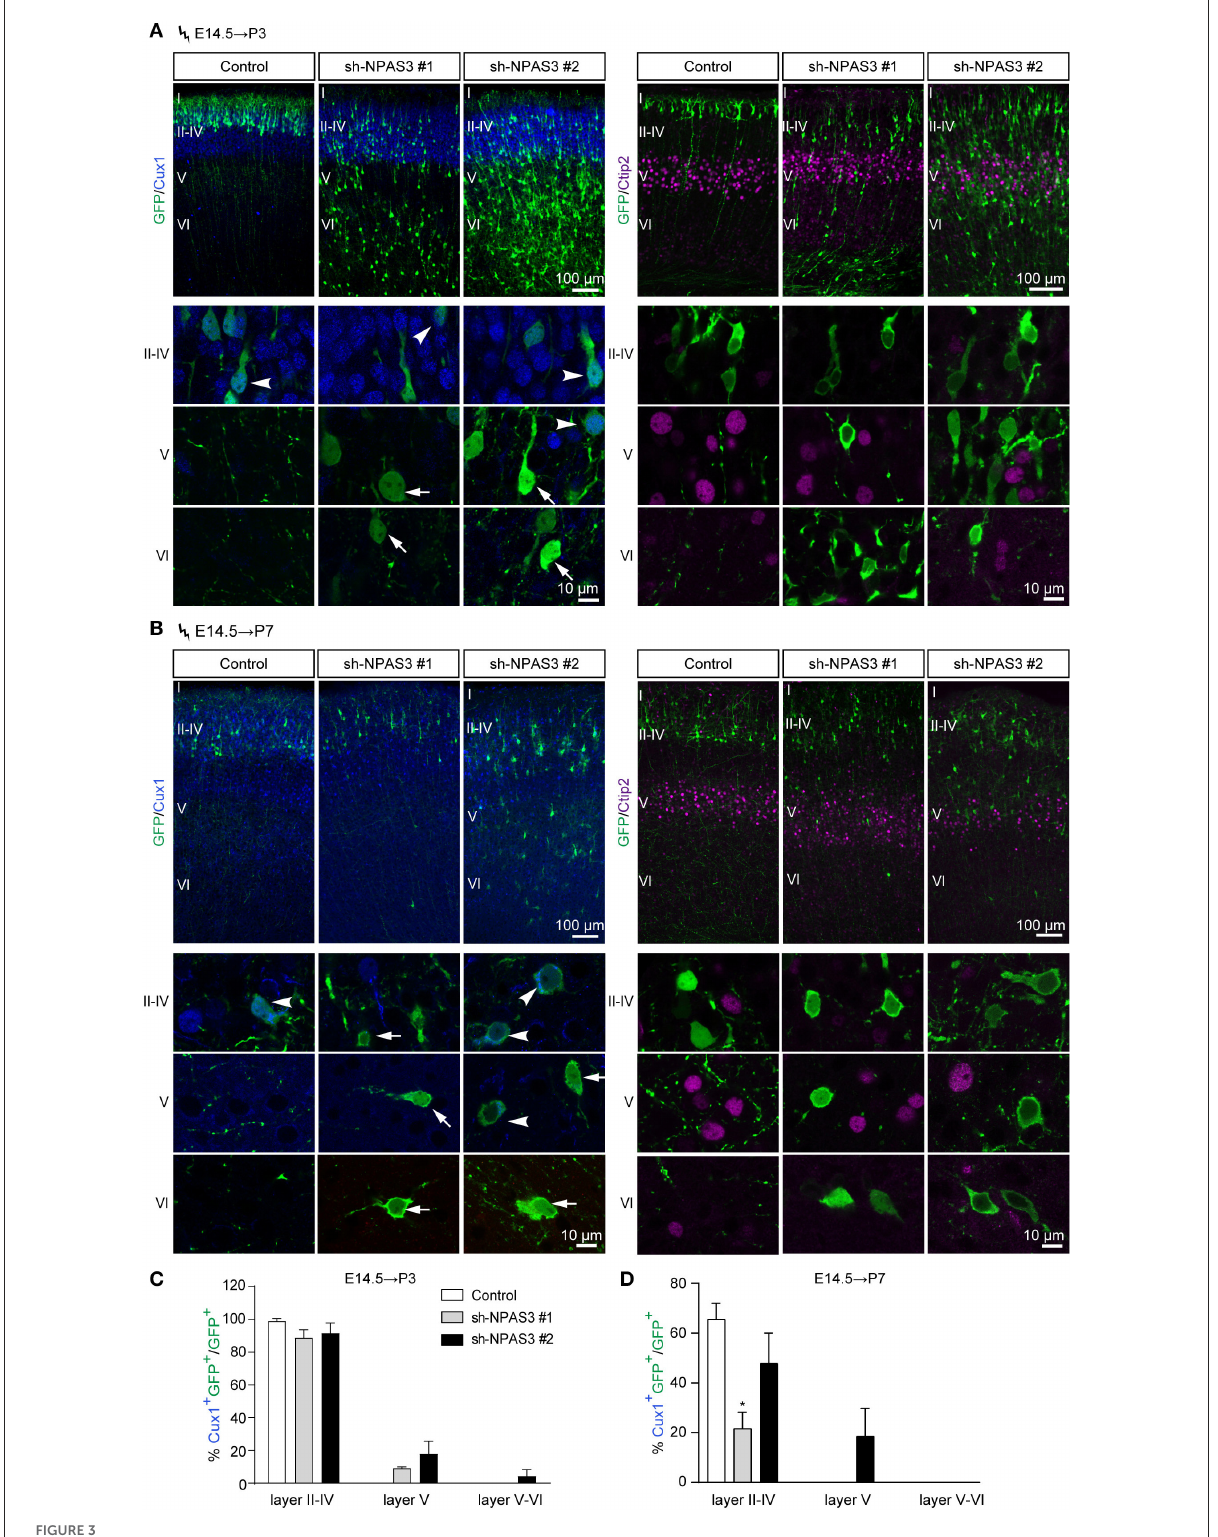
FIGURE3 Npas3 knockdown affected the laminar fate of cells detained in deep cortical layers. (A,B) Coronal sections of P3 (A) and P7 (B) brains electroporated at E14.5 were subjected to immunostaining with the anti-GFP antibody together with anti-Cux1 or anti-Ctip2